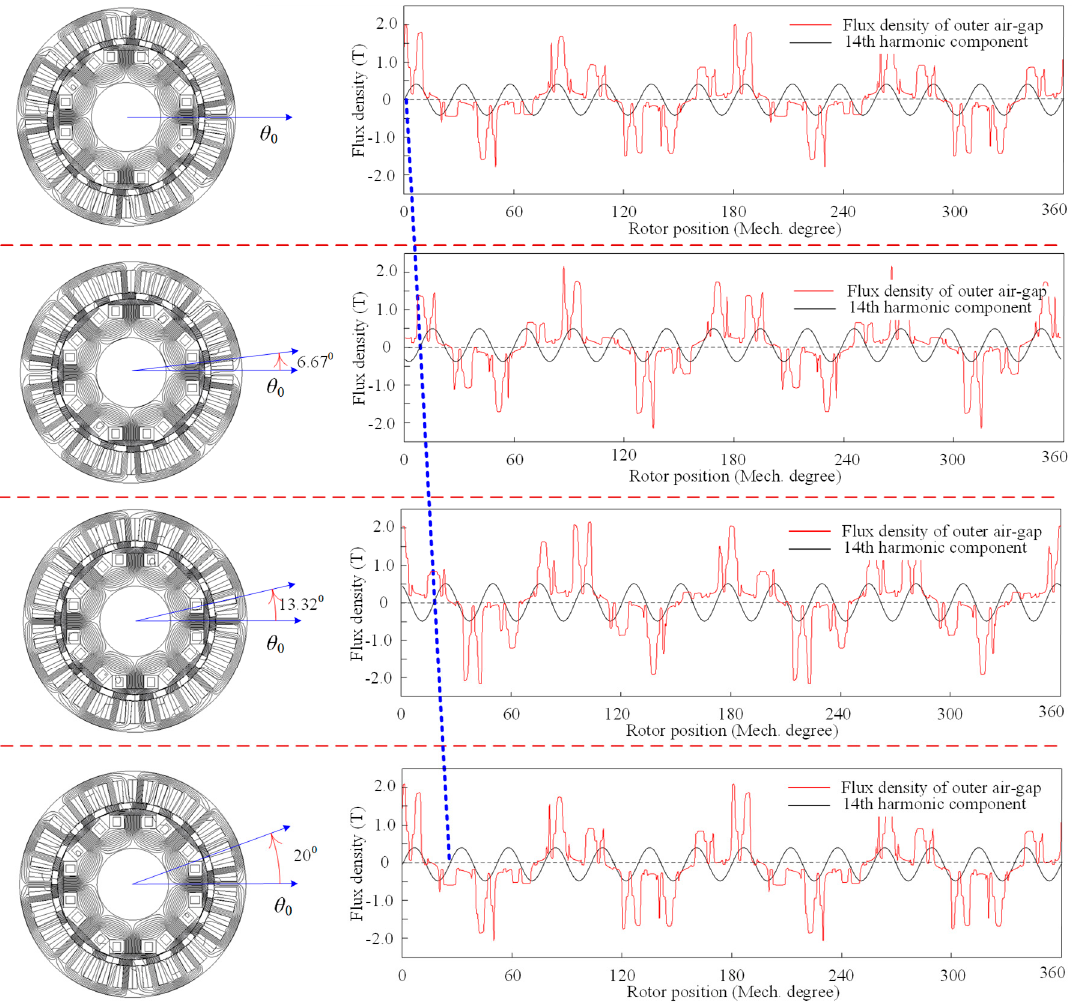
Figure 3. Operating principle.